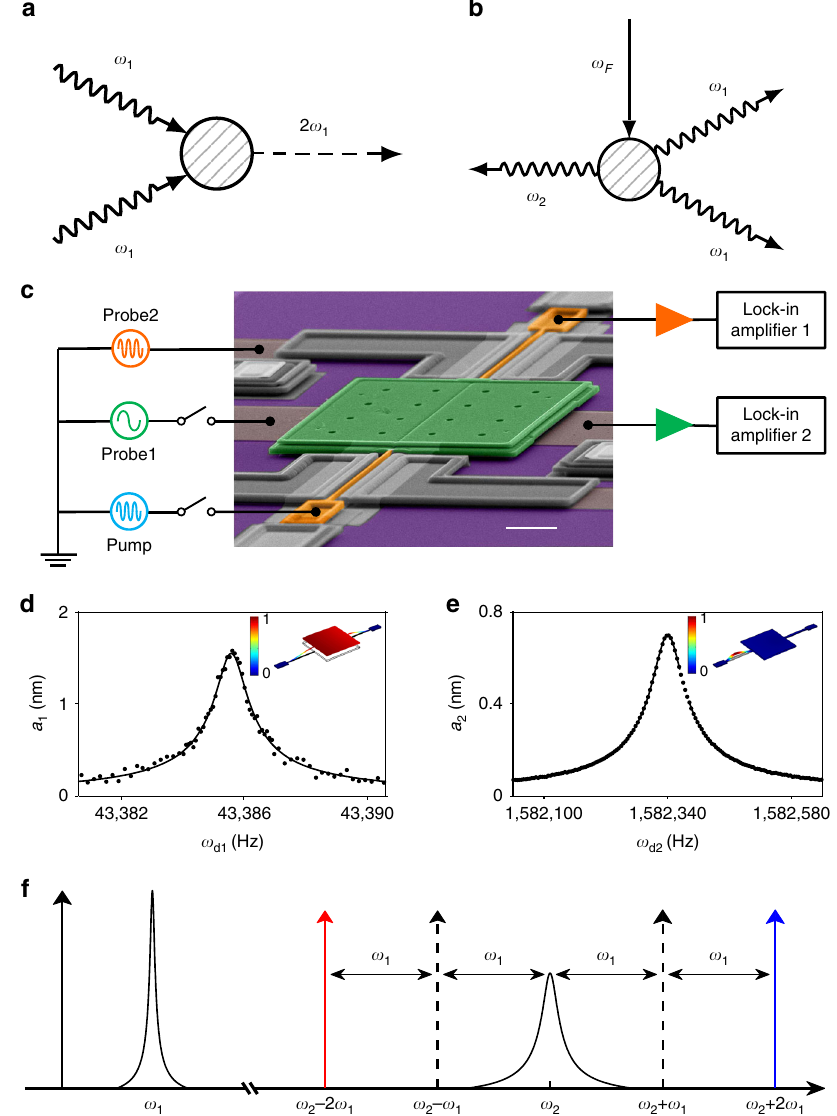
Fig. 1 Two-phonon transfer between the plate and beam modes of the electromechanical resonator. a Ordinary positive nonlinear friction involves transferring two phonons of the vibrational mode 1 (shown by the wavy lines) to excitations of the reservoir (the dashed line). b External pump at frequency ω F (the solid line) can create one phonon in fast-decaying mode 2 and two phonons in mode 1, inducing negative nonlinear friction in mode 1. c Colorized scanning electron micrograph of the electromechanical resonator with a schematic of the measurement circuitry. The white scale bar at the lower right corner measures 20 μ m. d The amplitude a 1 of the plate mode (mode 1) against frequency ω d1 of a small probe voltage (probe 1). The dots are measurements. The line is a fi t to yield parameters Γ 1 and Γ 2 . Inset: vibration pro fi le of the plate mode. The color bar gives the normalized displacement. e A similar plot for the beam mode (mode 2). f A sketch of the spectra of the plate mode and the beam mode centered at the mode frequencies ω 1 and ω 2 , respectively. Pumping at the secondary high-/low-frequency sidebands (red and blue arrows) generates negative/positive nonlinear friction in the plate